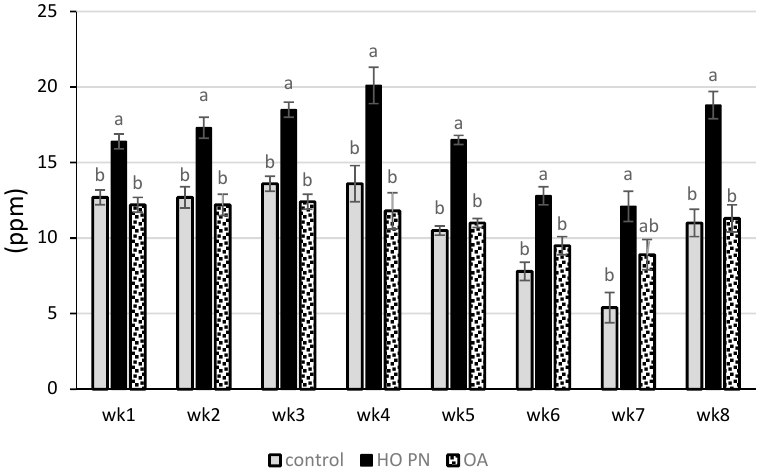
Figure 2. Effect of diet on the β -Carotene content of eggs produced. In total, 99 brown Leghorn (57 weeks of lay) hens were fed one of three isonitrogenous (18% crude protein) diets ad libitum for 8 weeks. Treatments: Control = conventional soybean meal and corn mash diet, HOPN = 20% unblanched high-oleic peanut + corn diet, OA = control diet supplemented with 2.64% food-grade oleic fatty acid oil. Beta-carotene analysis was performed by an AOAC-certified lab, ATC Scientific (Little Rock, AR, USA). β -carotene content in eggs was determined using AOAC 958.05 methods [14]. p -values at the various sampling time-points were the following: Week-1 p = 0.002, Week-2 p = 0.004, Week-3 p = 0.0003, Week-4 p = 0.006, Week-5 p < 0.0001, Week-6 p = 0.004, Week-7 p = 0.008, Week-8 p = 0.001. Each bar column represents the average ± the standard error for each experimental time-point, with 15 egg samples/treatment group (5 egg samples per replicate, 3 replicates) and a total of 45 eggs analyzed at each time-point. a,b Bar columns with differing superscript are significantly different ( p < 0.05).